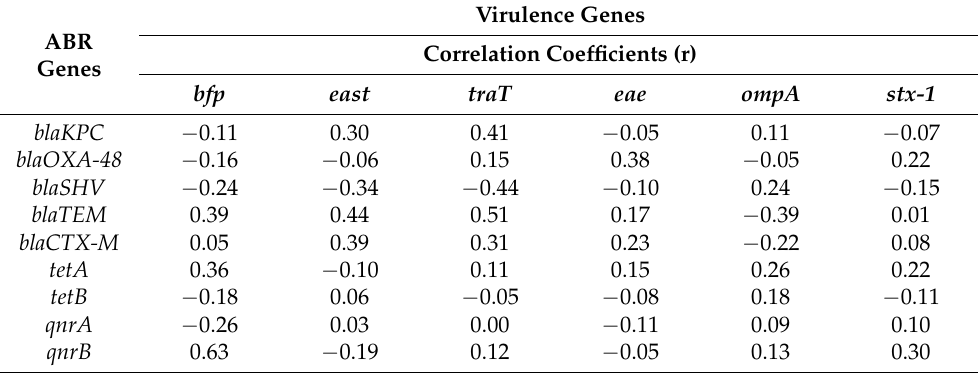
Table 4. Correlation between resistance and virulence genes of MDR E. coli isolates.